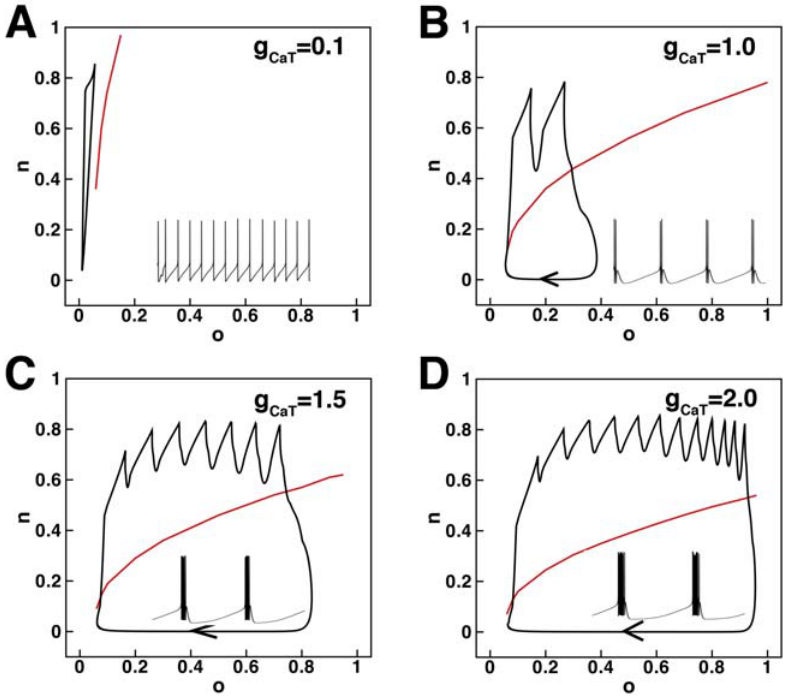
Figure 7. Fast slow analysis of bursting in a reduced CA3 model . The phase plot shows the projection of the burst trajectory onto the slow- variable n – o plane ( n : the activation gate of Ca V 3.1; o : the activation gate of Ca 2 + -dependent K + channel). Direction of movement is indicated with arrows. Inset within each phase plot is the corresponding membrane potential timecourse over 500 ms. (A) g CaT =0.1 mS/cm 2 ; (B) g CaT =1.0 mS/cm 2 ; (C) g CaT =1.5 mS/cm 2 ; (D) g CaT =2.0 mS/cm 2 . The red curve is the voltage nullcline (dV/dt=0) of the fast subsystem with n and o as parameters. The region above the nullcline is the repetitive firing region. Below the curve is the silent